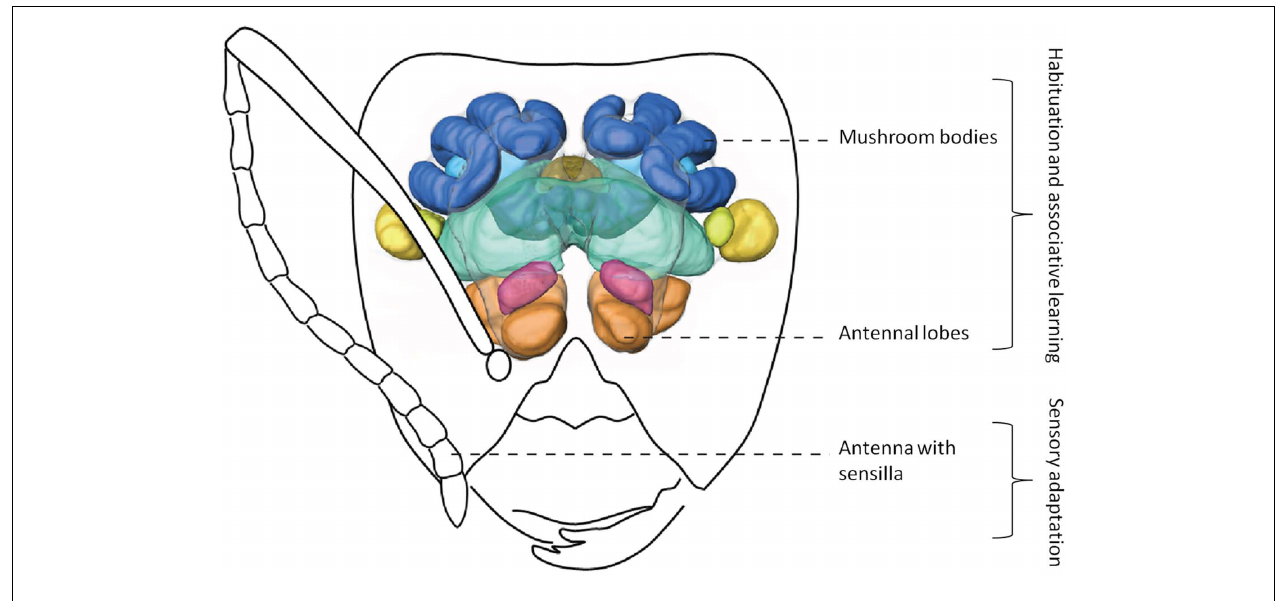
FIGURE 2 | Simplified olfactory system of ants. Odors are detected by antennae, the information is transferred to the antennal lobes where it is integrated. Afterward, this information can be sent to higher order